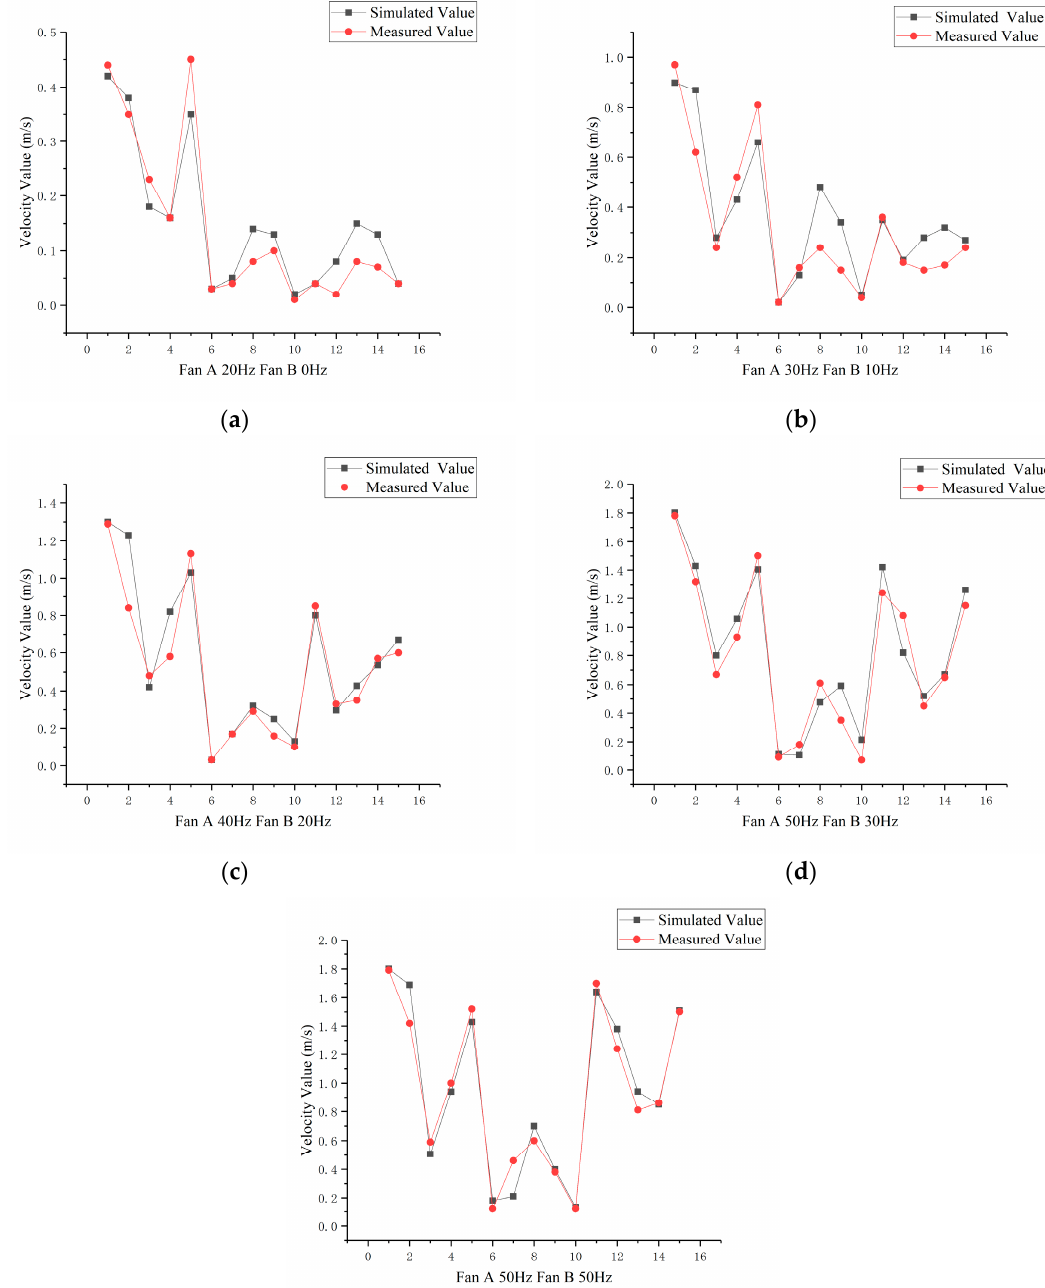
Figure 10. Numerical comparison of empty broiler chamber under ( a )work condition 5; ( b )work condition 4; ( c )work condition 3; ( d )work condition 2; and ( e )work condition 1. Table 5. Error values under different working